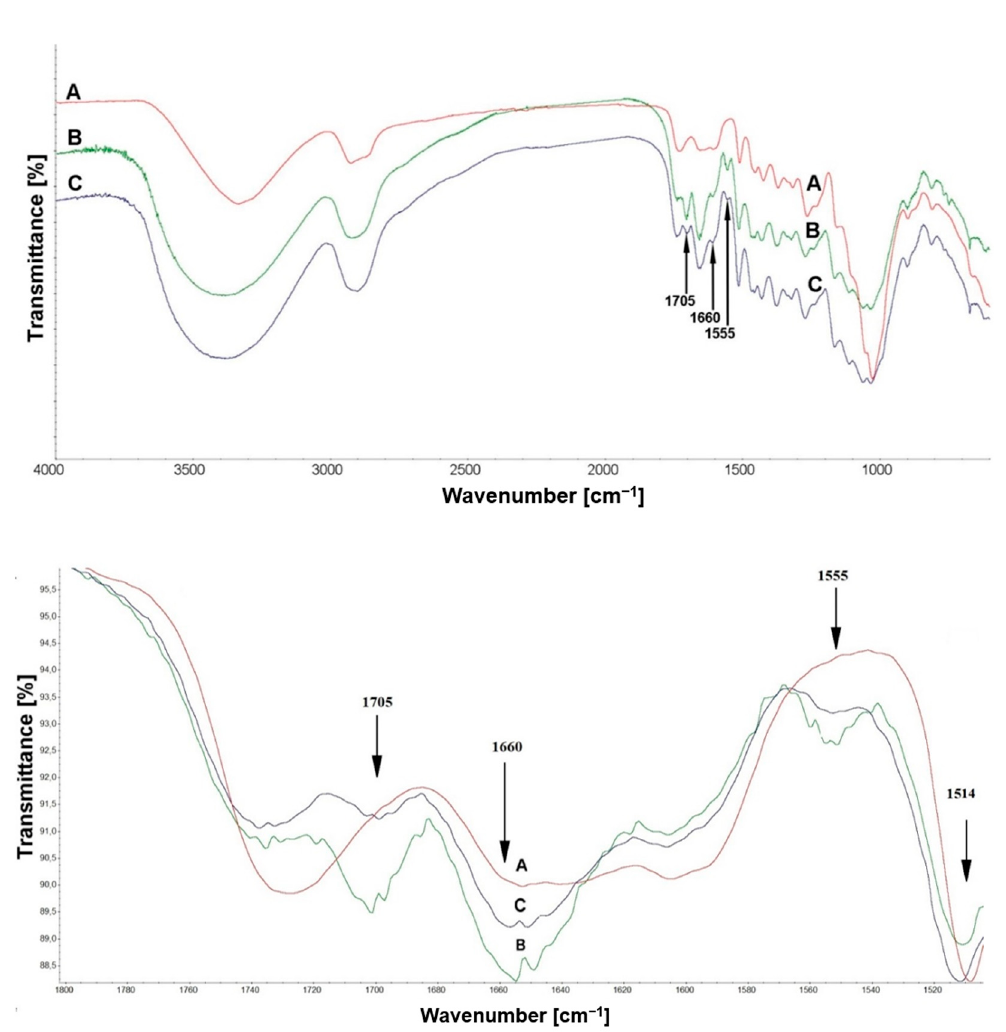
Figure 4. FTIR spectra of Scots pine (A) and wood treated with caffeine (B), and treated wood after leaching (C) . Additionally, in the case of samples treated with caffeine after the leaching proce- dure, there were noticeable changes in the intensity of the bands characteristic of caffeine vibrations at 1705 cm − 1 , 1660 cm − 1 , and 1555 cm − 1 . The intensity of these bands decreased for impregnated samples after leaching. This is related to caffeine leaching from the wood structure.